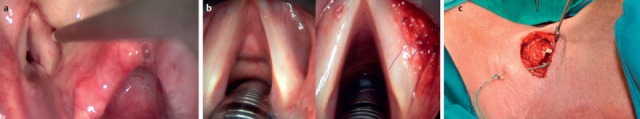
a – injection augmentation of the right vocal fold; b – implantation augmentation of the right vocal fold; c – left-sided thyroplasty type I with Friedrich prosthesis.